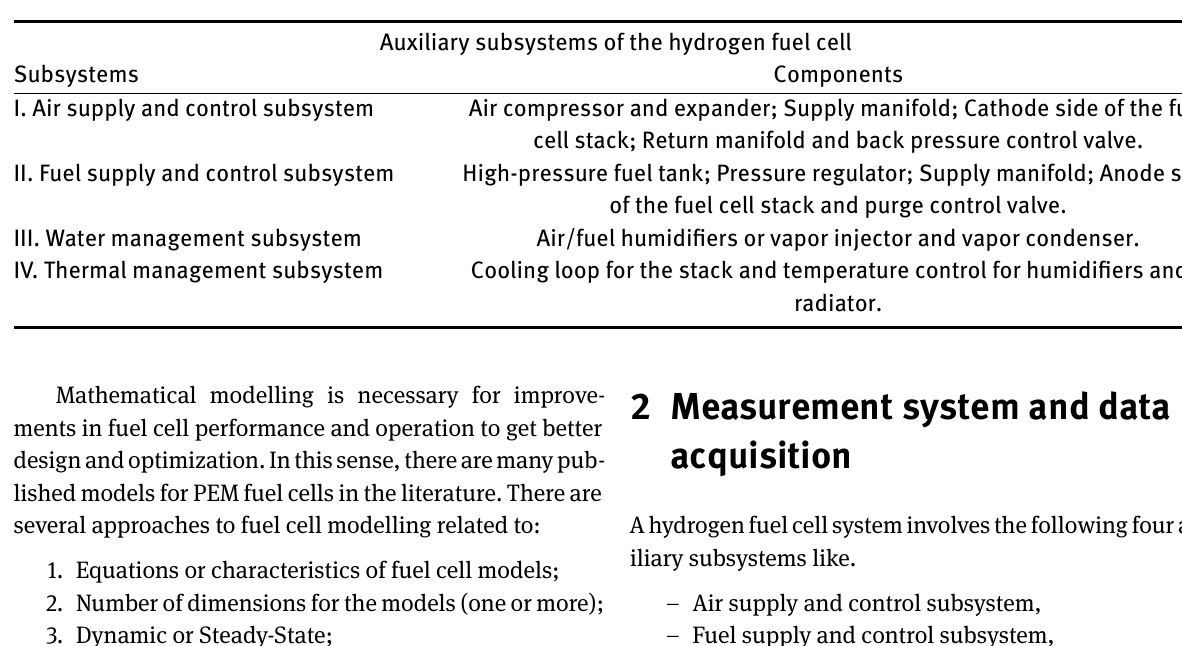
Table 1: Subsystems of the hydrogen fuel cell system and their